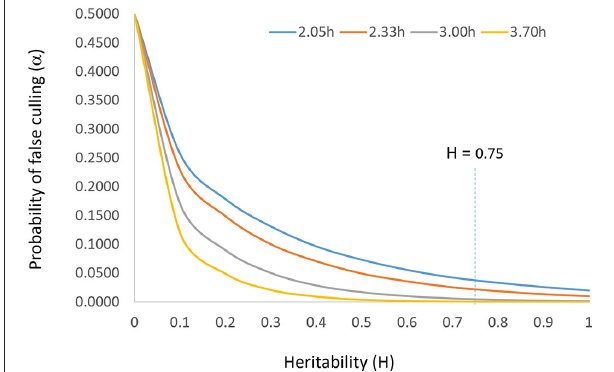
FIGURE 2 | The relationship between heritability (Hor h 2 ) and probability of false culling ( α ) at four levels of selection intensity ( i ). It is suggested that the probability of false culling that can be tolerated be set according to the population size ( n ) such that α = 1/ n ; i can then be determined by α by consulting the normal distribution table. The vertical line of H the target heritability to be achieved for reliable selection.